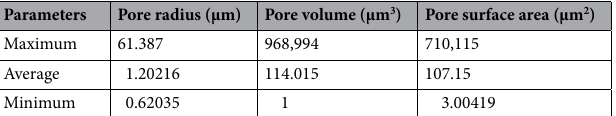
Table 7. Quantitative parameter statistics of pore model in nylon-uncured rubber composite.